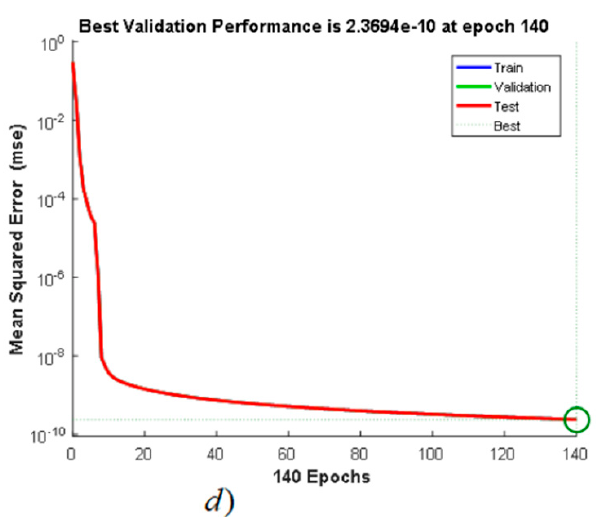
Figure 11. ( a ) Time diagrams of the input signals x 1 and x 2 for training the neural network; ( b ) Time diagrams of the input signals y 1 and y 2 for testing the neural net; ( c ) Time diagrams of the desired and the output signal of the neural network after testing and time diagram of the error signal expressed as a difference between the desired and the output signal of the feed-forward neural network; ( d ) A visualization of the minimizing of the mean square error over epochs.